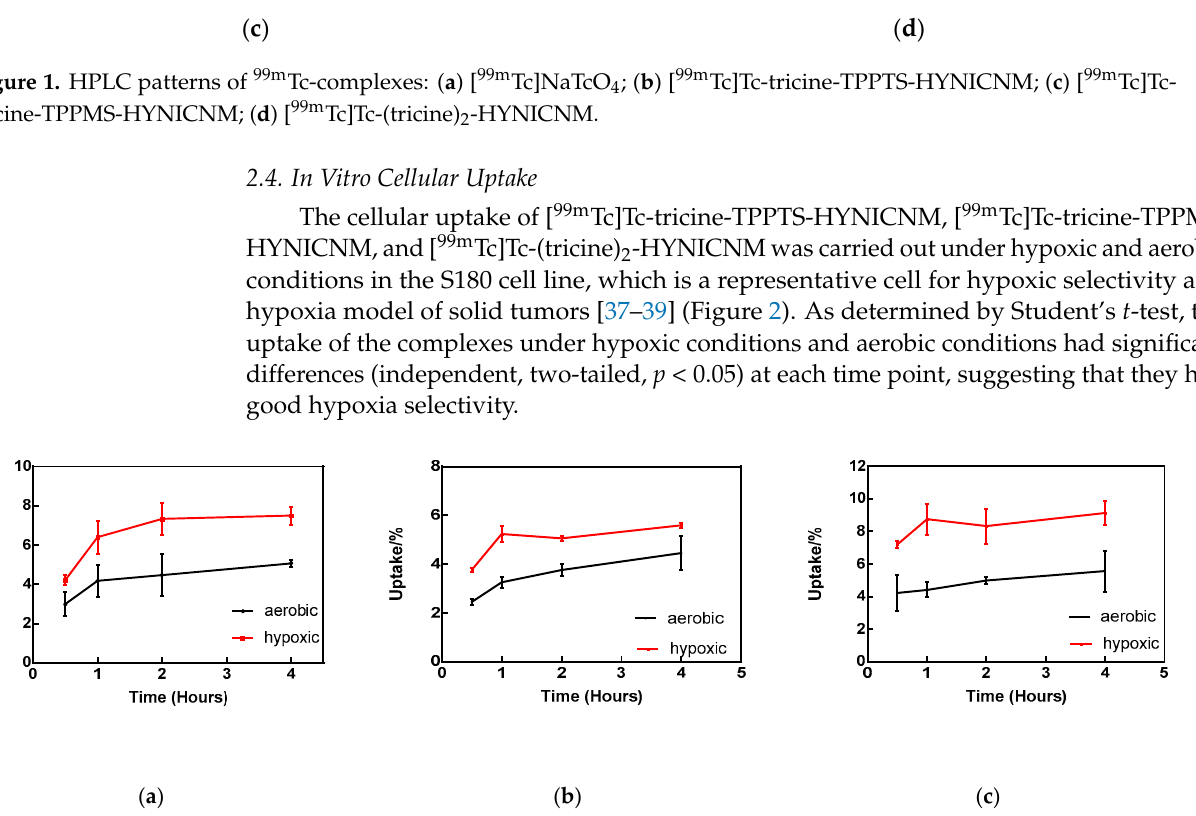
Figure 2. Cellular uptake of 99m Tc-complexes: ( a ) [ 99m Tc]Tc-tricine-TPPTS-HYNICNM; ( b ) [ 99m Tc]Tc-tricine-TPPMS-HYNICNM; ( c ) [ 99m Tc]Tc-(tricine) 2 -HYNICNM.